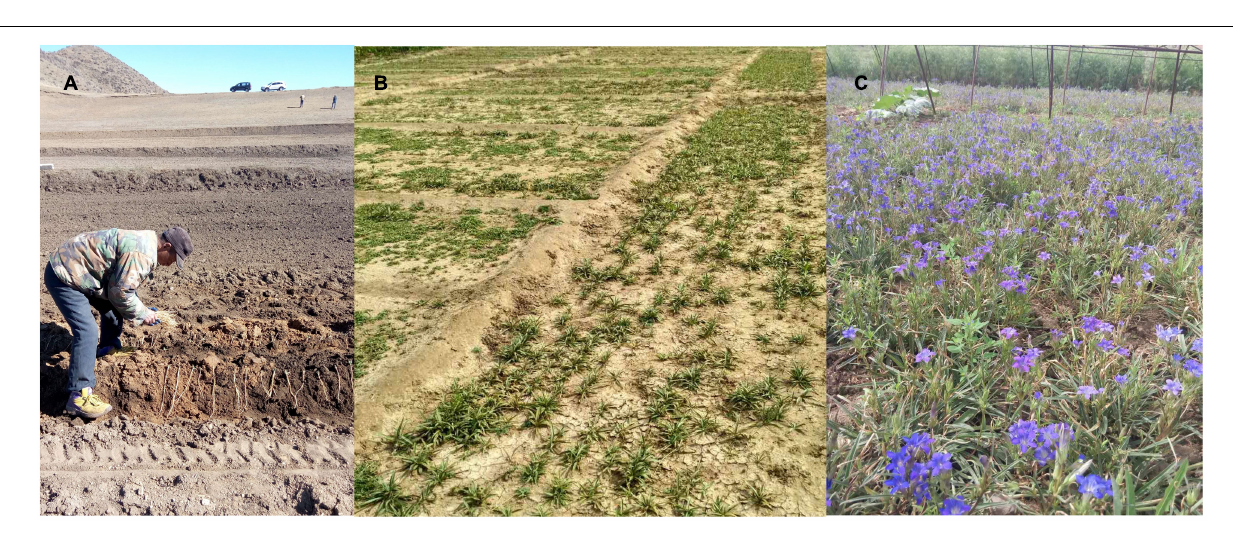
FIGURE 5 | The production base of Gentiana dahurica in Wuchuan County. (A) The process of transplanting G. dahurica by farmers; (B) field of G. dahurica ; (C) G. dahurica in